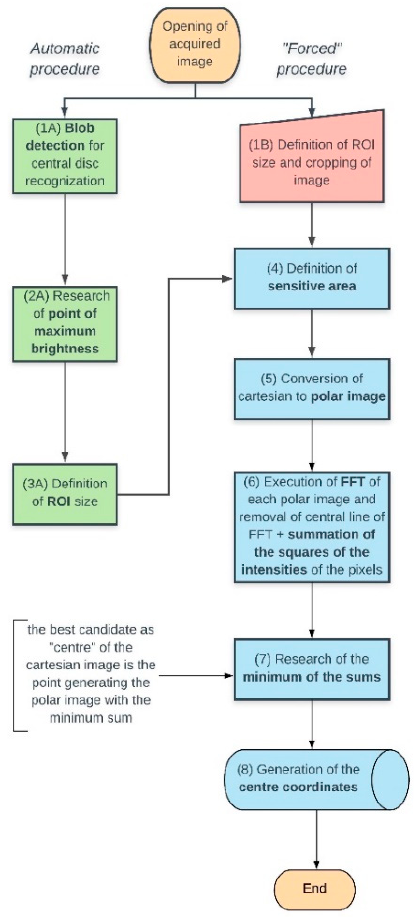
Figure 12. Block diagram of the FFT-based approach to the problem.